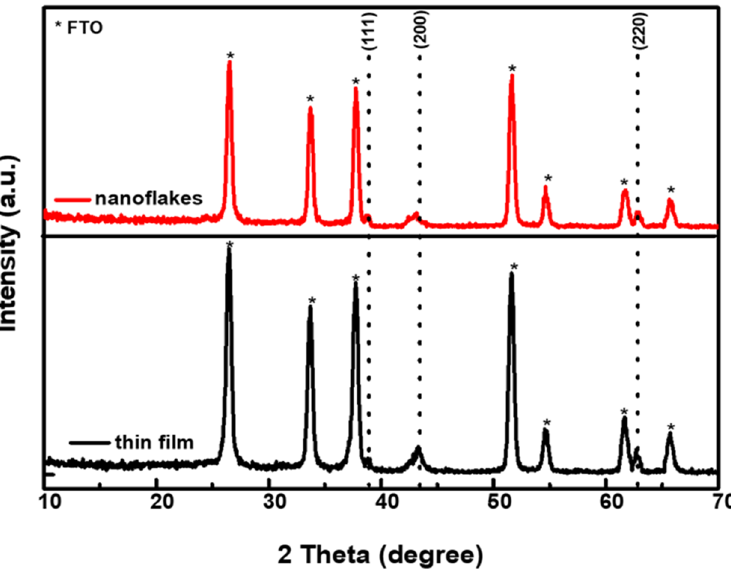
Figure 5. XRD patterns of the NiO x thin film and nanoflakes on the FTO substrates.